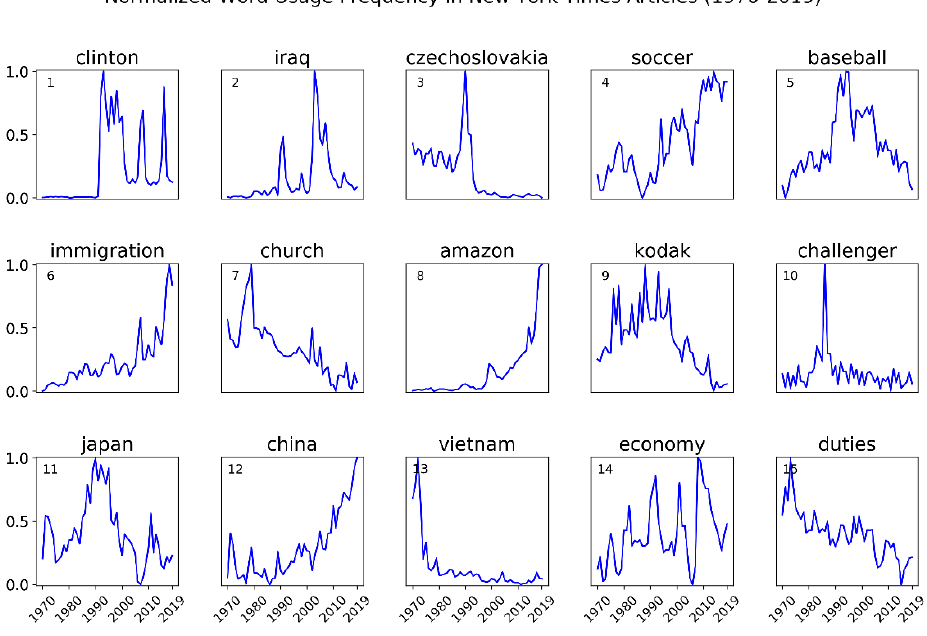
Fig. 1. Normalized min-max frequency counts of several sample words in New York Times articles Plotting absolute frequency counts across several outlets allows an analyst to compare the prevalence of certain topics across different media outlets. Fig. 2 shows absolute frequency counts of several sample words across four different news outlets. Clear differences and commonalities in the absolute prevalence of different words across outlets are apparent in the